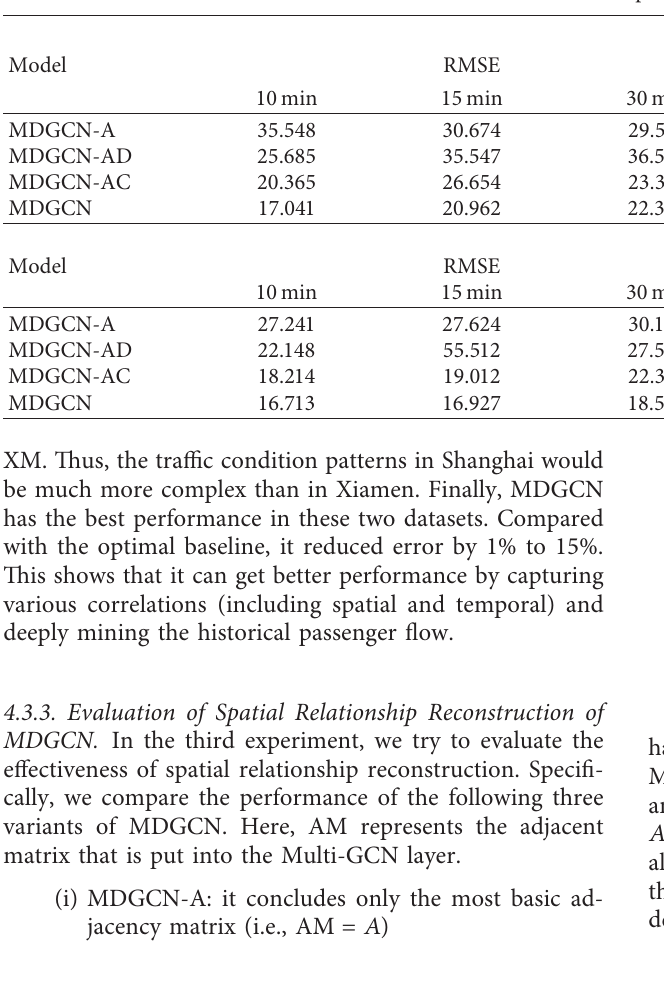
Table 4: The evaluation results of spatial relationship